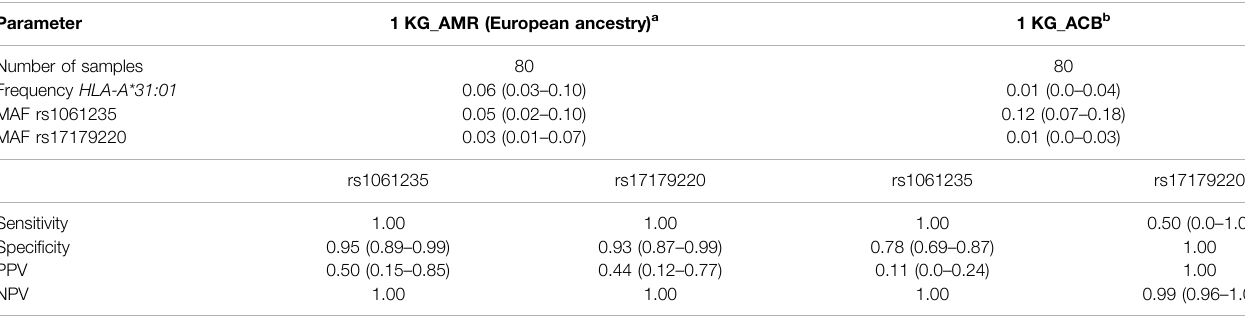
TABLE 3 | Predictive performance of rs1061235 and rs17179220 for tagging HLA-A*31:01 in 1KGP samples.